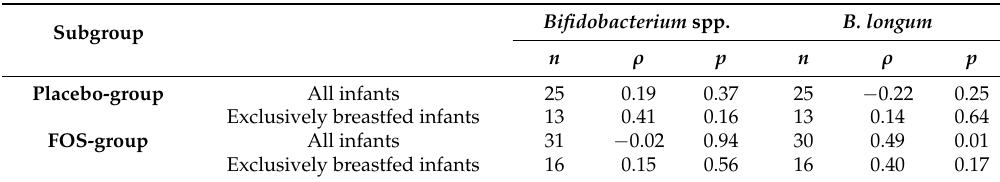
Table 2. Subgroup analysis for relation between the number of fecal bifidobacteria in mothers and their neonates.